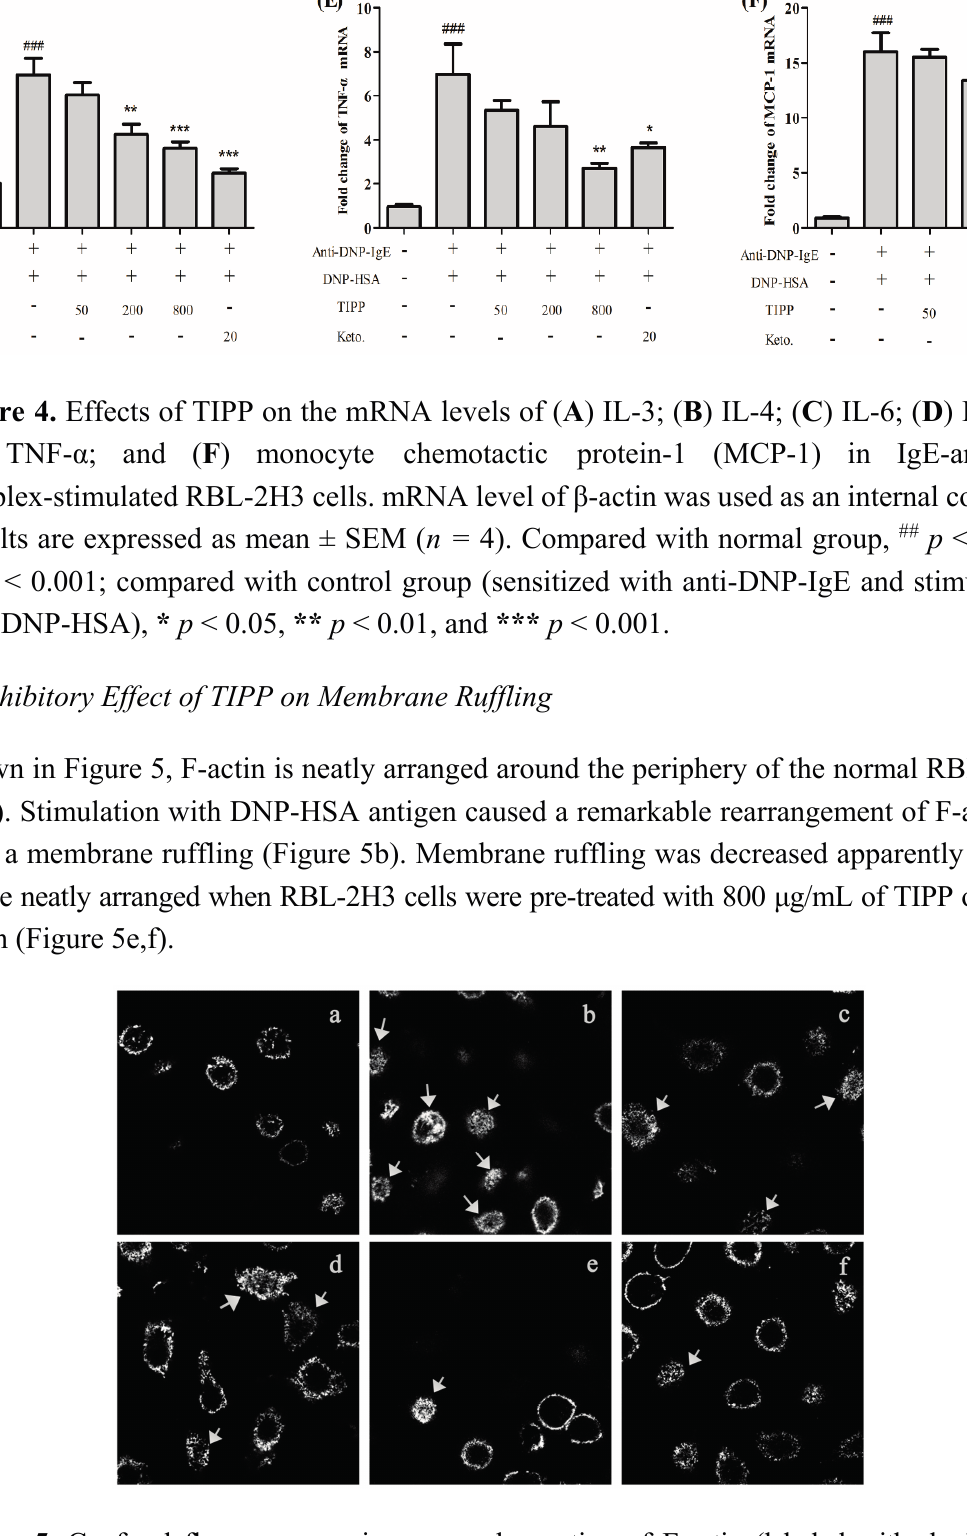
Figure 5. Confocal fluorescence microscope observation of F-actin (labeled with rhodamin- phalloidin) in RBL-2H3 cells. The arrow represents membrane ruffling caused by F-actin rearrangement. ( a ) IgE-sensitized RBL-2H3 cells stimulated with PBS; ( b ) IgE-sensitized RBL-2H3 cells stimulated with DNP-HSA for 30 min; ( c – f ), IgE-sensitized RBL-2H3 cells, pretreated with 50, 200, and 800 μ g/mL of TIPP or 20 μ g/mL of ketotifen, then stimulated with DNP-HSA for 30 min. Magnification: